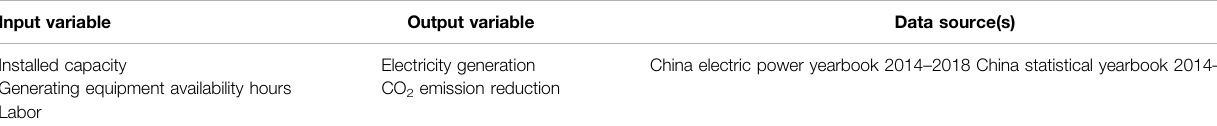
TABLE 1 | Input and output